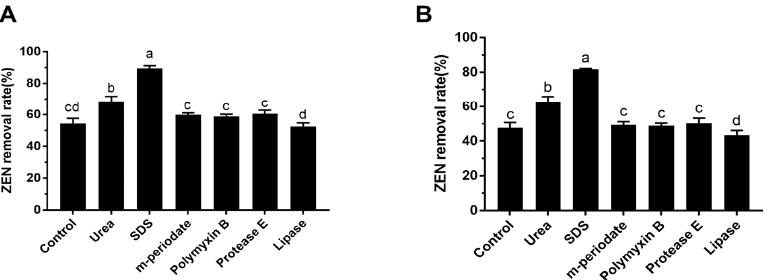
Figure 5. Effect of chemical and enzymatic treatments on the ZEN removal rate of pickle-derived LAB. ( A ) L. paracasei 85; ( B ) L. buchneri 93. a, b, c, and d: bars not sharing the same letters are significantly different ( p < 0.05) from each other.